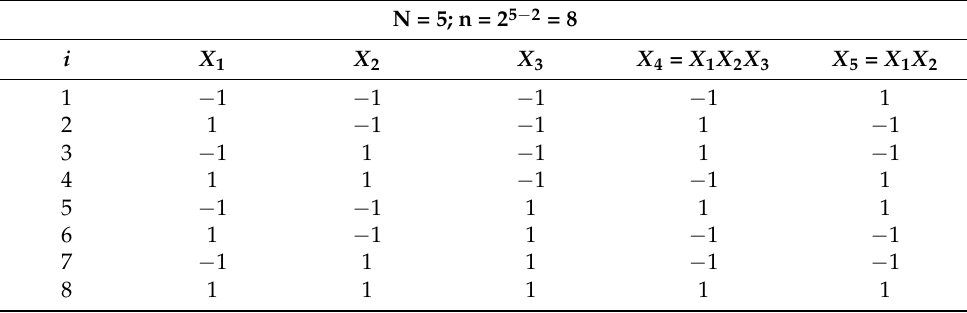
Table 5. The first two-level fractional plan.